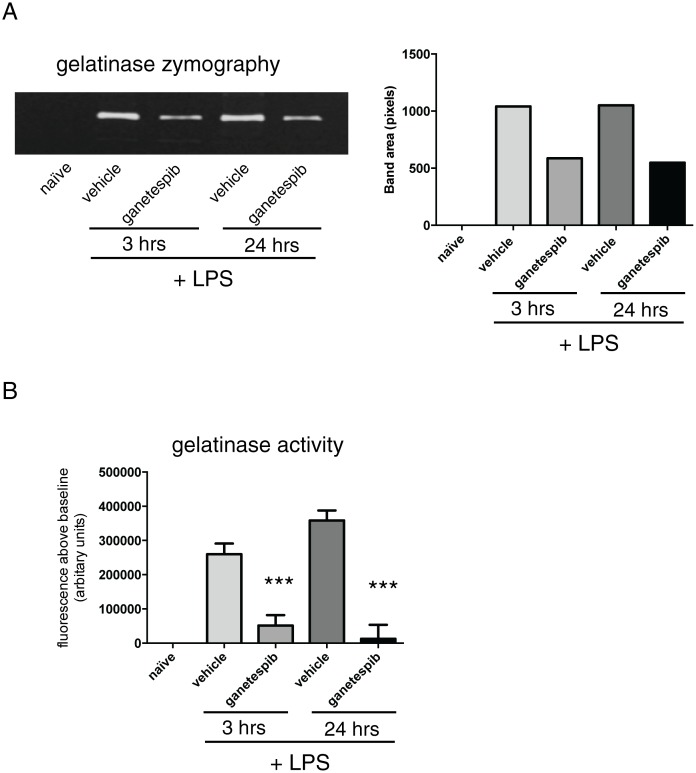
Ganetespib inhibits net gelatinase and MMP-9 gelatinase activity in BALF.Balb/c mice were treated with Ganetespib (50 mg/kg, i.v. or vehicle) and challenged with LPS (10 µg/mouse, tn). (A) 102–105 kDa (size markers not shown) MMP9 gelatinase activity of pooled BALF samples determined by gelatin zymography. Left panel, original lucent bands revealed on post-stained gel; right panel corresponding band densitometry in arbitrary units (image pixels). Pooled samples, no statistics. (B) Net gelatinase activity in unfractionated whole BALF collected 3 and 24 h post LPS was determined in individual mice by fluorogenic substrate assay. Data are mean ± SEM. n = 8 mice per group. (naïve; n = 4). *** p<0.001 compared to LPS/vehicle treated mice.